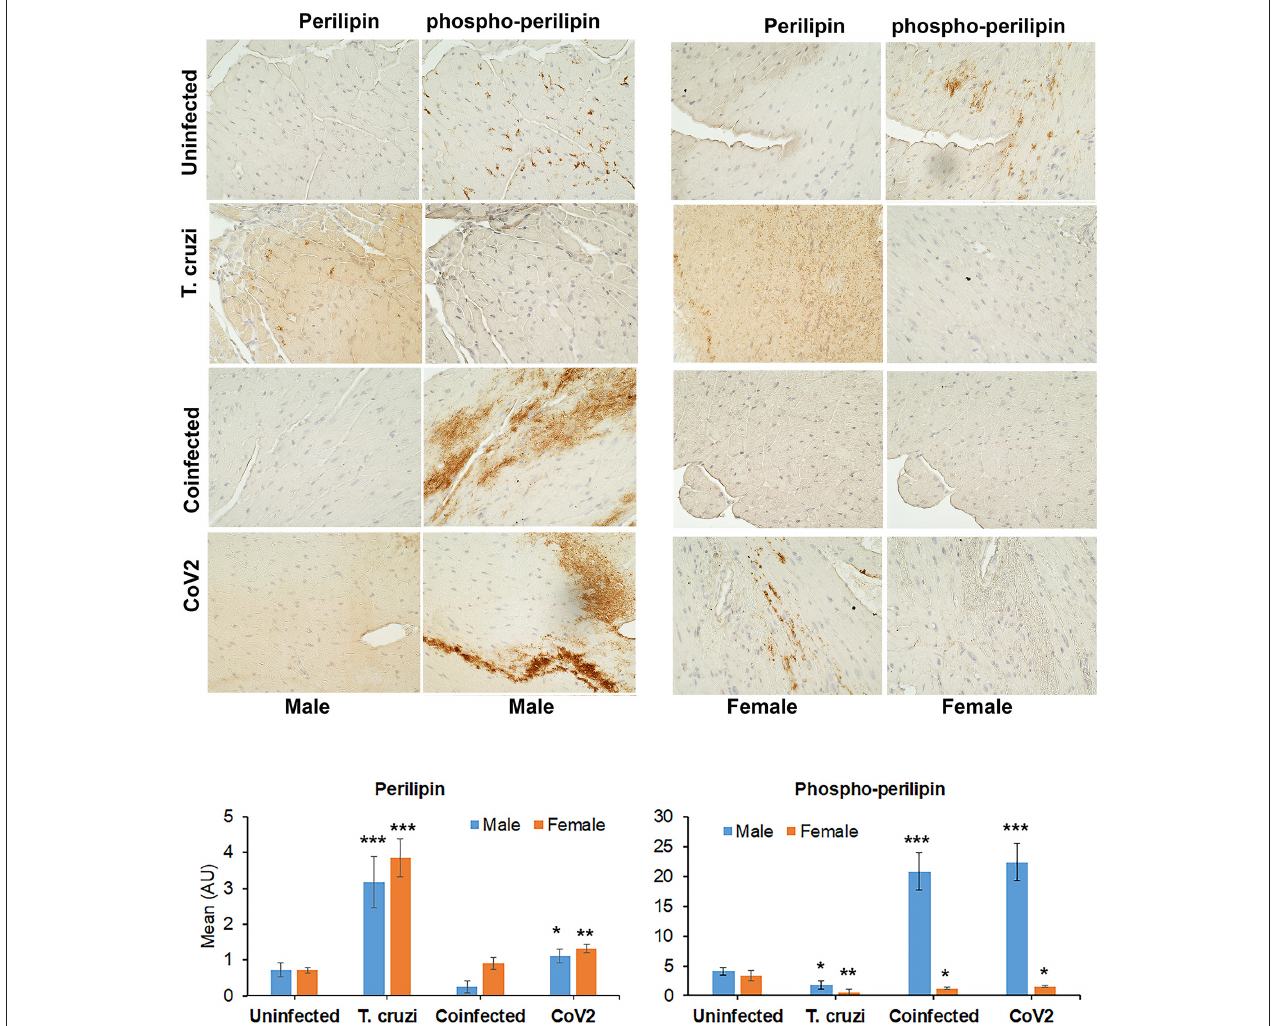
FIGURE 4 | Immunohistochemistry staining (top panel) of huACE2 mouse myocardium using anti-perilipin (left) and anti-phospho-perilipin (right) antibody. The stained sections show altered levels of perilipin and phospho-perilipin during indeterminate T. cruzi infection and coinfection in both male and female mice compared to uninfected and CoV2 infected mice. IHC staining intensity (bottom panel) was analyzed using ImageJ software. Positive staining intensities of perilipin and phospho-perilipin were calculated and plotted separately ( n = 4 mice, a minimum of five images/section were analyzed). The error bars represent standard error of the mean. * p < 0.05, ** p < 0.01 and *** p < 0.001 compared with uninfected sex matched mice (M, male; F,